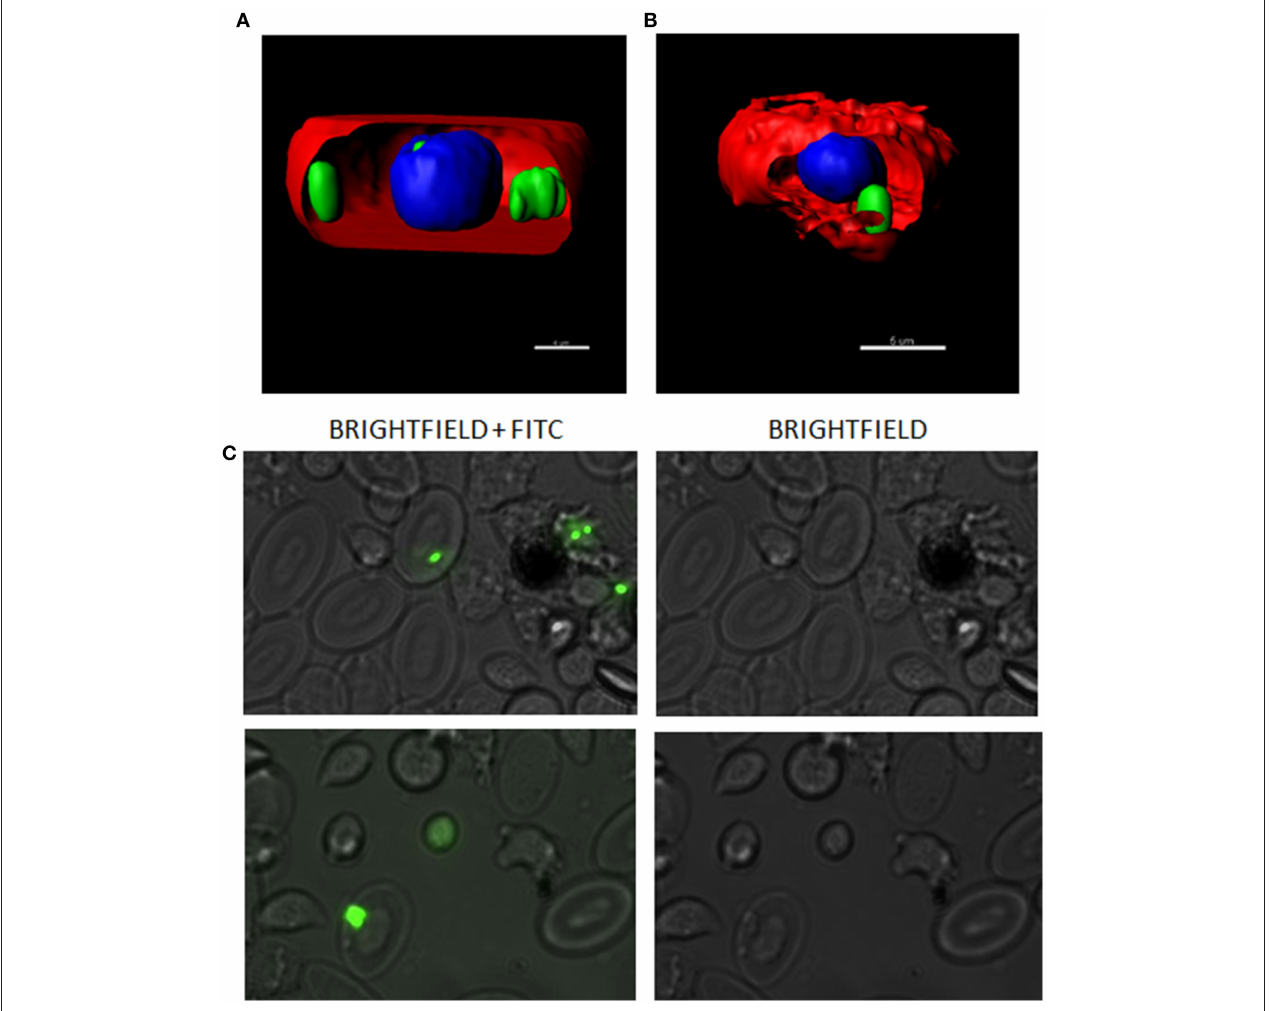
FIGURE 2 | Confocal microscopy images digitalized using z-stack. RBCs incubated with (A) 80 µ g/mL IB TNF α or (B) 160 µ g/mL IB frg16G − VHSV for 24h. IBs are showed in green, cell membrane (CellMask TM ) in red and nucleus (Hoechst-stained) in blue. (C) IBs monitorization in vivo in cells obtained from head kidney of rainbow trout injected intravenously with 5.5 mg/kg of IB TNF α , 3h post- injection. Representative bright-field and FITC microscopy images taken with 40 × magnification.